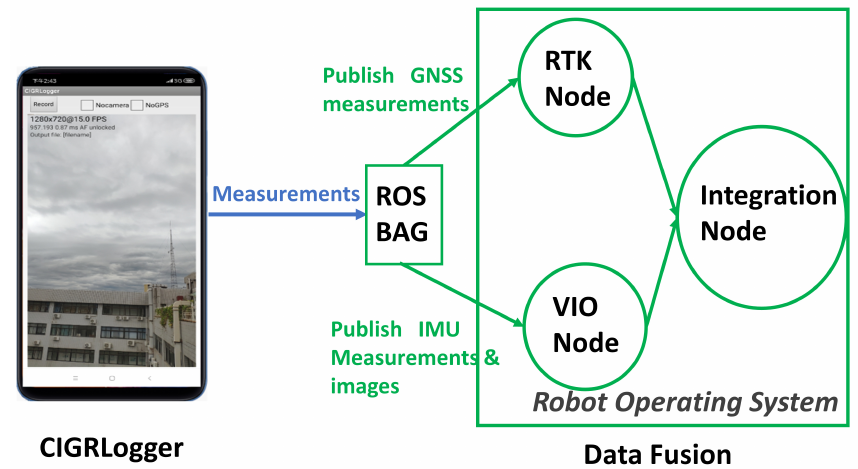
Figure 6. The CIGRLogger and the flow chart of the software